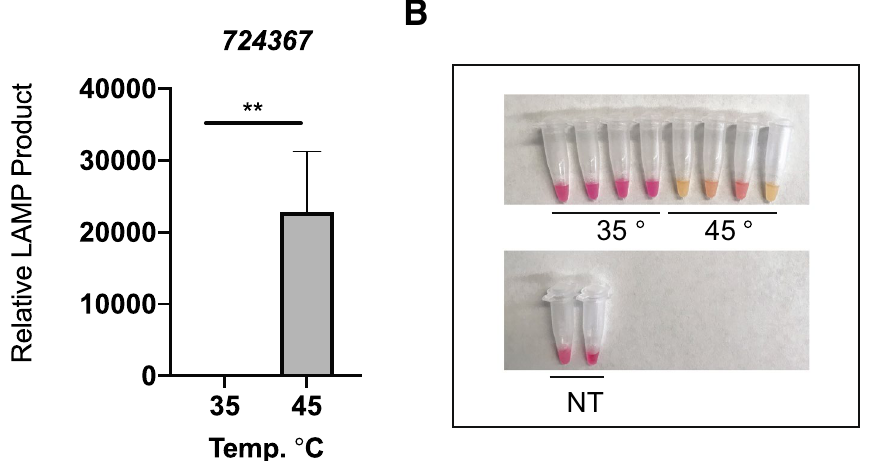
Figure 7. RT-LAMP assay detects heat-induced induction of the 724367 l(2)efl gene. Transcript levels of the l(2) efl 724367 gene in midgut tissue from adult bees captured at the landing board and maintained for 4 h in cages at either 35 °C or 45 °C as assessed by RT-LAMP using quantitative real-time fluorescence ( A ) or end-point colorimetric ( B ) read-outs. For real-time fluorescence, mean ± SEM is shown and represents relative expression values of l(2)efl 724367 (see “Methods” for details). Statistical significance is noted as *p < 0.05, and **p <